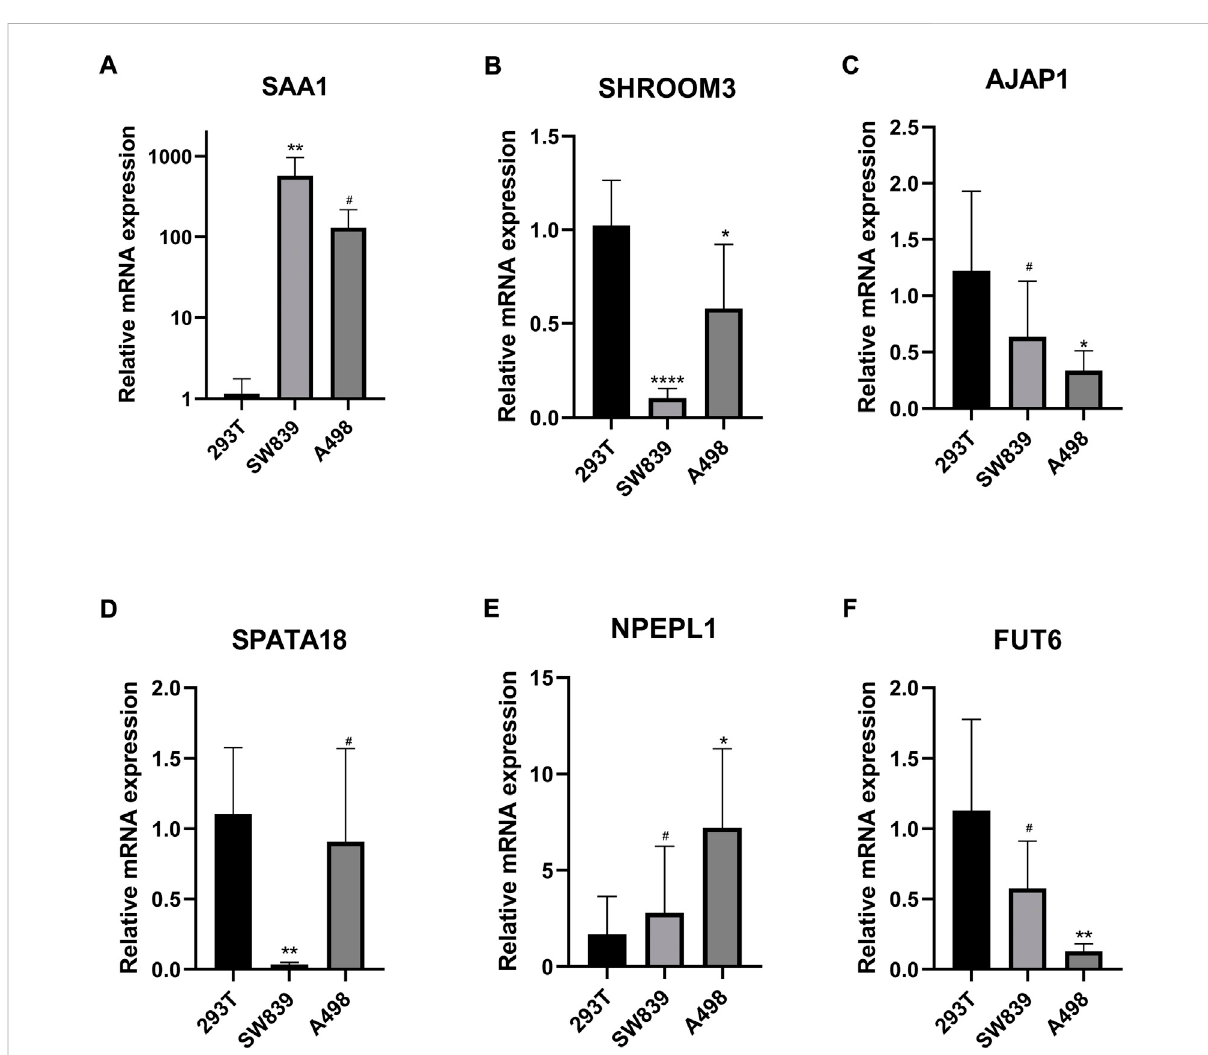
FIGURE 12 (A – F) Validationoftheexpressionlevelsofthemethylation-drivengenesatthecellularlevel.* p < 0.05,** p < 0.01,*** p < 0.001,**** p < 0.0001, # p >